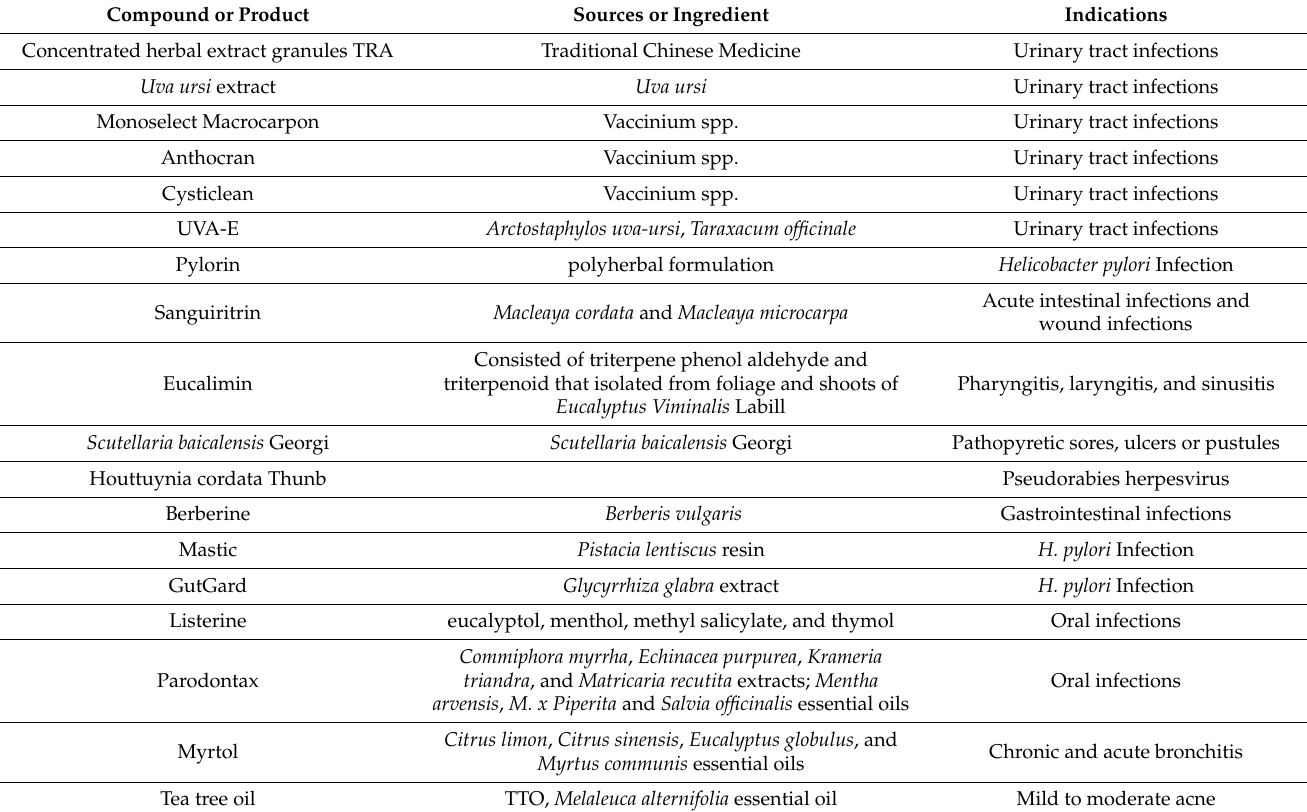
Table 2. Examples of t herbal-derived products as antibacterial agents in clinical trials or markets. Compound or